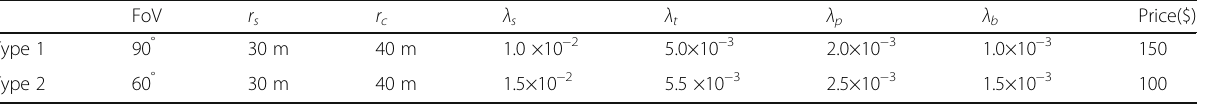
Table 3 Parameters of the SN types used in the deployment of the case-study surveillance WSN